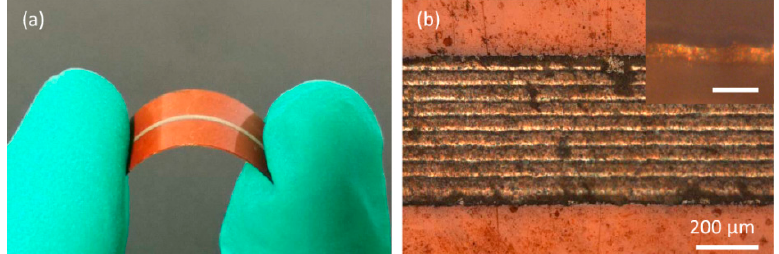
Figure 2. The laser-scripted MS transmission line on a PI film. ( a ) The photo image of a MS line. ( b ) The microscope image of a silver membrane. The inset shows the cross-sectional view of the silver membrane. The scale bar in the inset indicates 10 μ m .